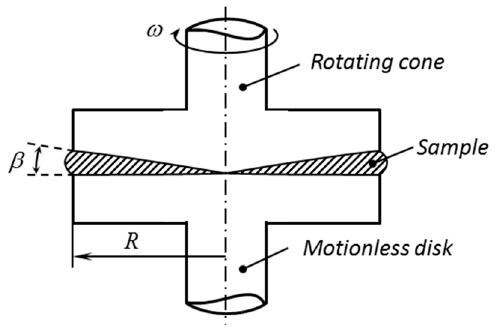
Figure 1. Cone-and-plate rheometer – notation.